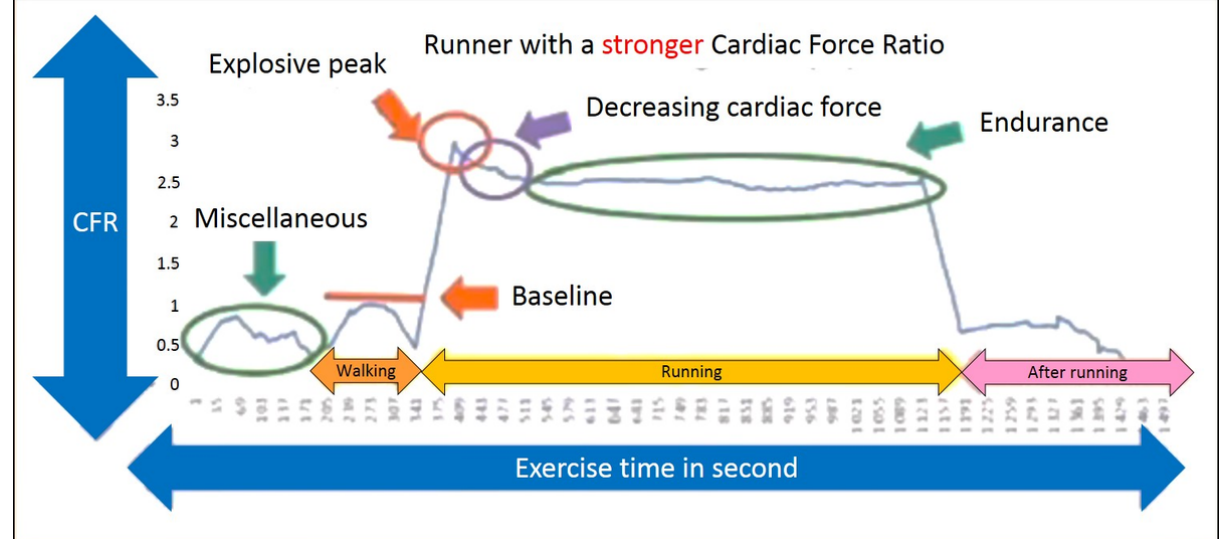
Figure 2. Runner with stronger cardiac force during 3000-meter